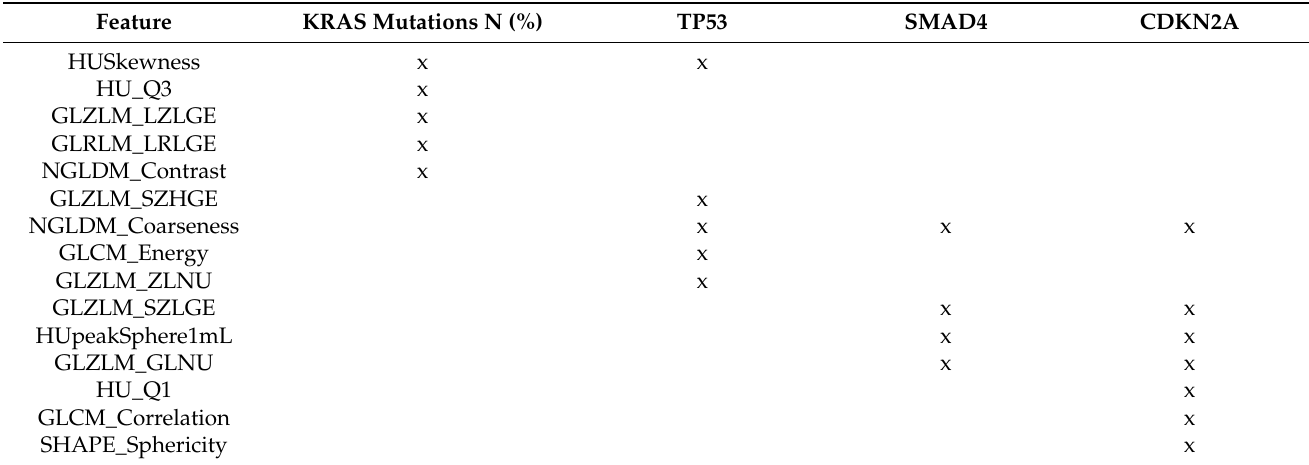
Figure 2. Boxplots demonstrating the Youden Index comparing method 1 ( upper row ) and method 2 ( lower row ). Table 5. Feature importance of method 2 for each gene mutation with a fixed set of features based on the complete sample.